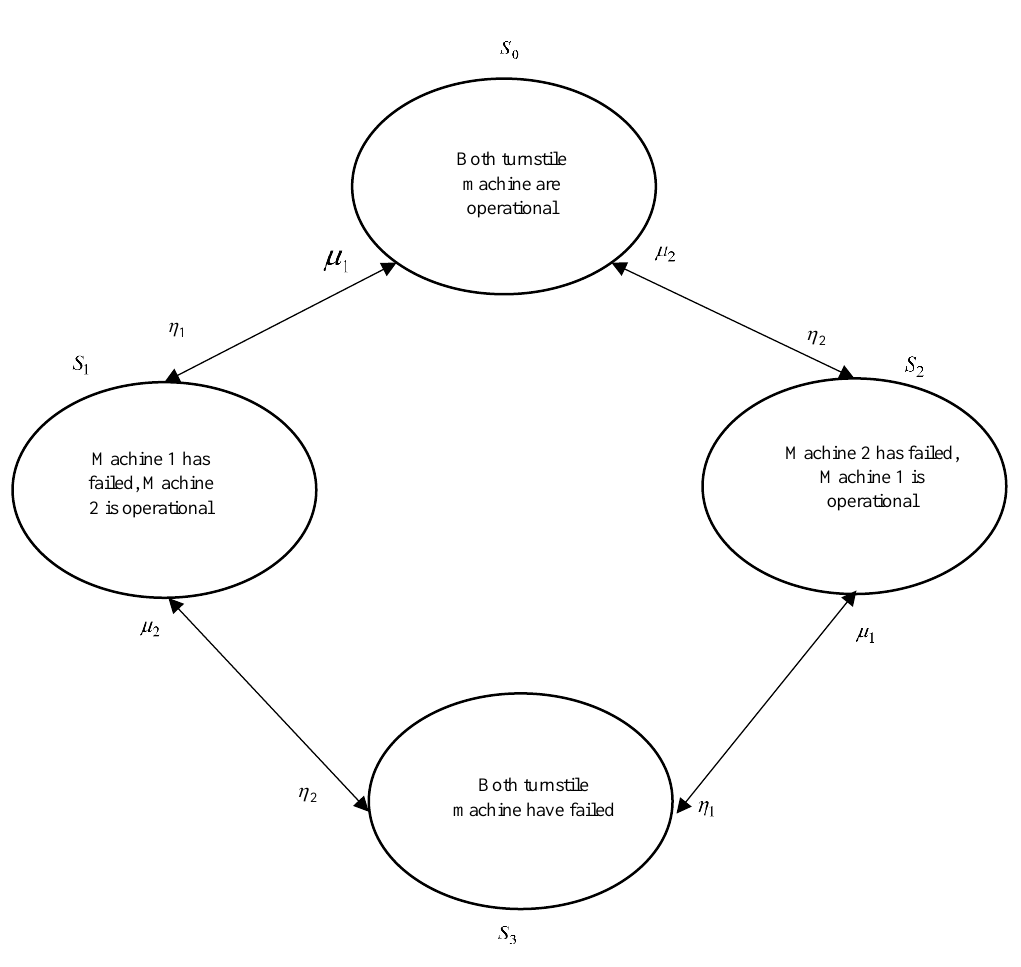
Figure 2. State transition diagram of turnstile